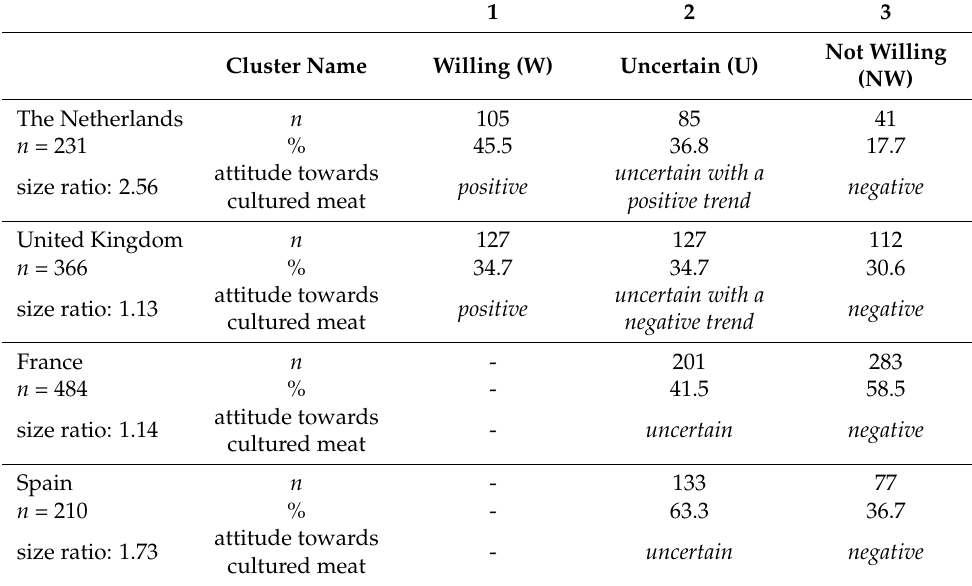
Table 3. Summary of the clusters for each